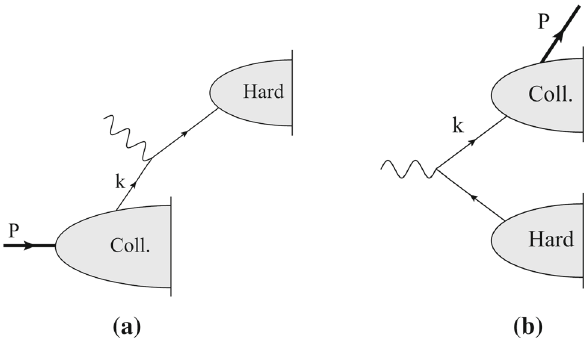
Fig. 4 Pictorial representation of DIS ( a ) and of e + e − → H X ( b ). In both cases, there is at least one hard real emission, which produces a collinear factor completely crossed by the final state cut. Consequently it can be reabsorbed in the hard factor of the cross